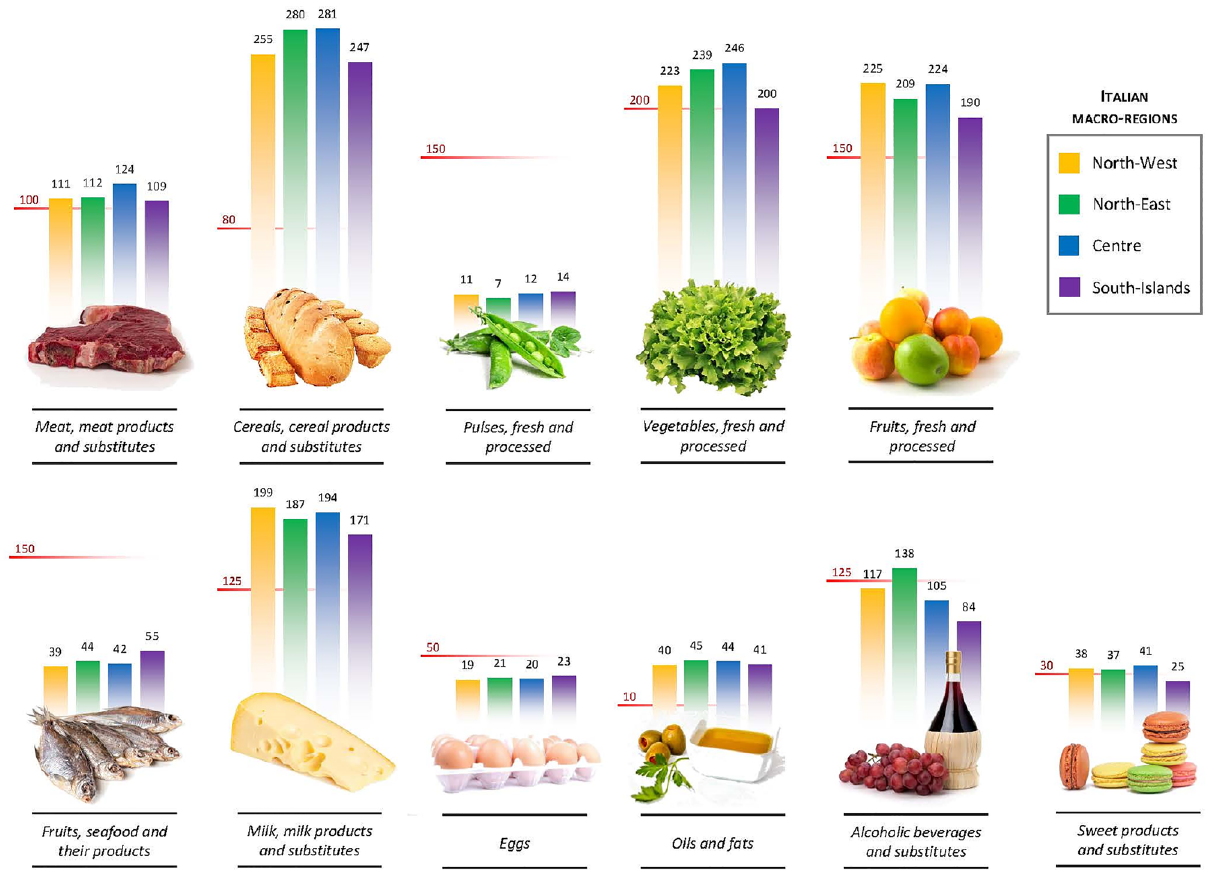
Figure 1. Mean individual daily consumption by food category in male and female adults (18–64 years) in the four Italian macro-regions (INRAN-SCAI, 2005–2006). Numbers are expressed in grams per day. Red horizontal lines represent the standard portion sizes for each food category, expressed in grams per day.